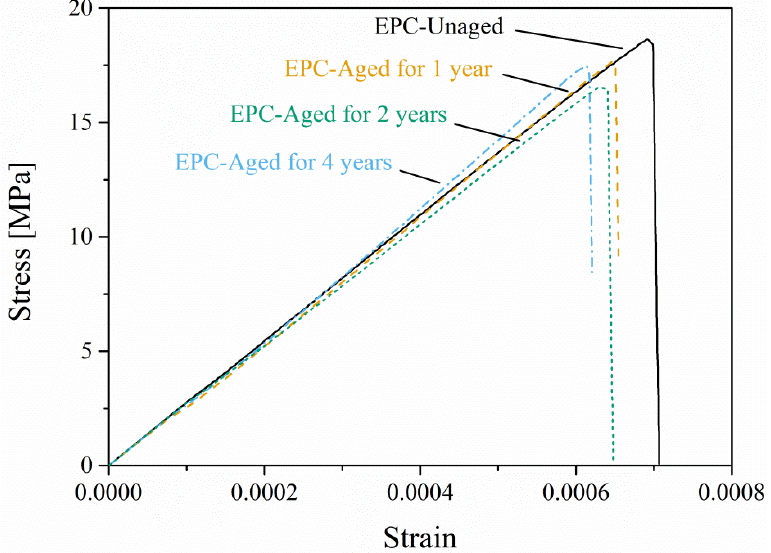
Figure 7. Stress–strain curves of EPC after various accelerated aging times under four-point bending. Table 2. Flexural strength and ultimate bending moment of EPC after various accelerated aging times. Equivalent Aging Time